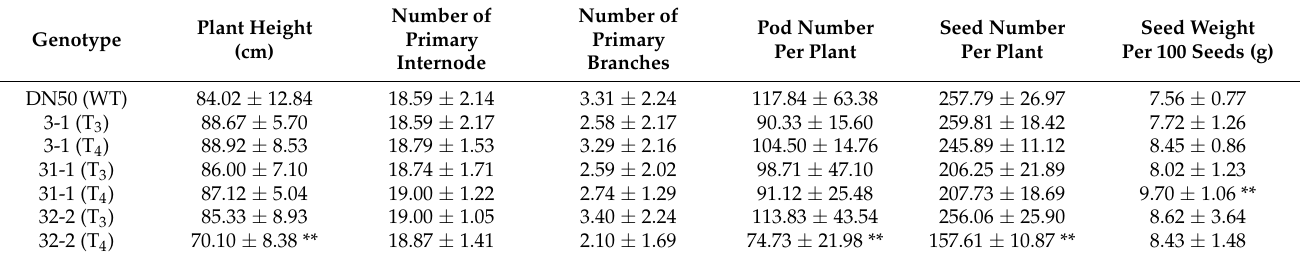
Table 2. Agronomic performance of GmWRI1a-OE lines and WT plants in field.